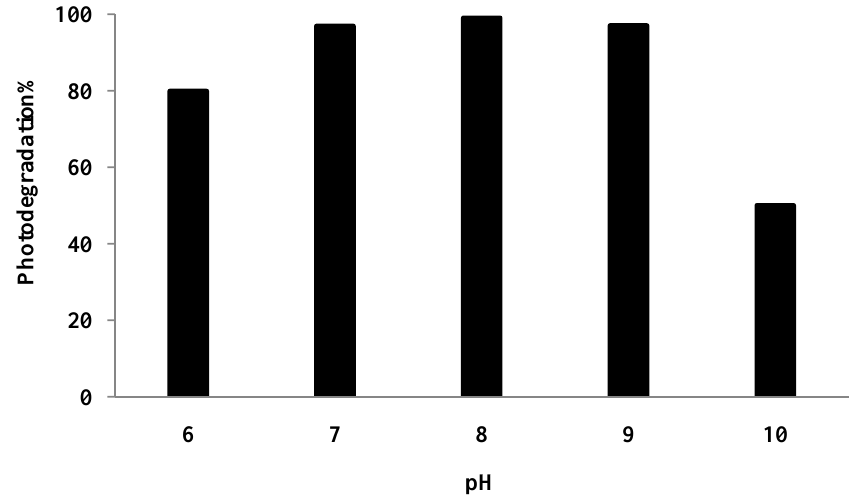
Figure 5. Photocatalytic degradation of p -cresol at variation initial pH under UV irradiation, initial p -cresol concentrations = 100 ppm, amount of photocatalyst = 2.5 g/L, end of 6 h.